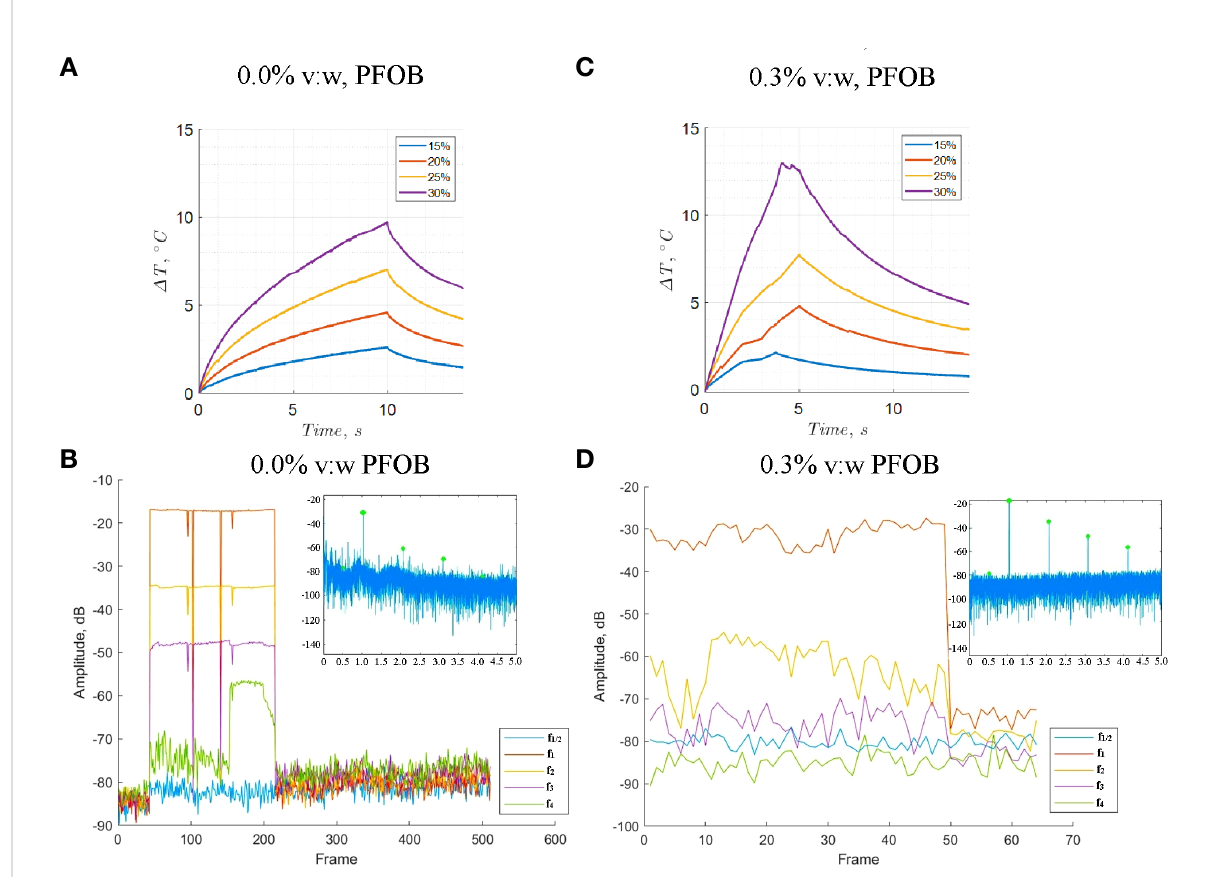
FIGURE 5 Hydrophone temperature measurements and change in acoustic spectra harmonics with time. (A) Temperature measurements in a control gel phantom. The measurements at 67 W were repeated three times. (B) Harmonic traces of control phantom with 0.0% v:w emulsion at 67 W.